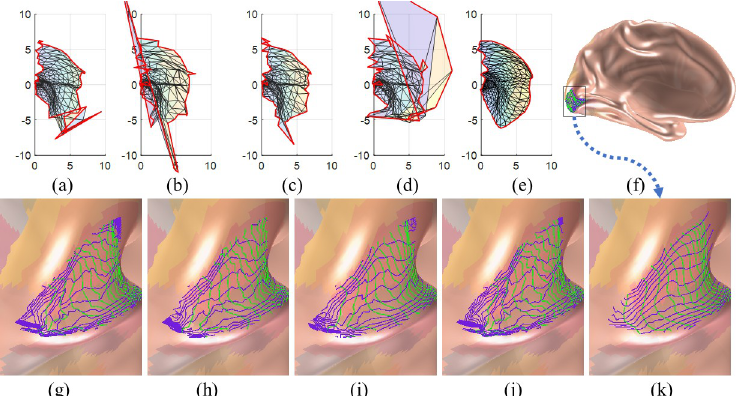
Fig 9. Results on the first observer: (A) the raw retinotopic map on the 2D parametric domain; (B)-(E) results from the Average, Median, Laplacian, and proposed methods, respectively; (F) the whole inflated left mesh; (G) the raw map on the cortical surface; (H)-(K) results on the inflated surface, in the same order of (B)-(E). In (A)-(E) the x axis is the visual x coordinate, and the y axis is the visual y coordinate.